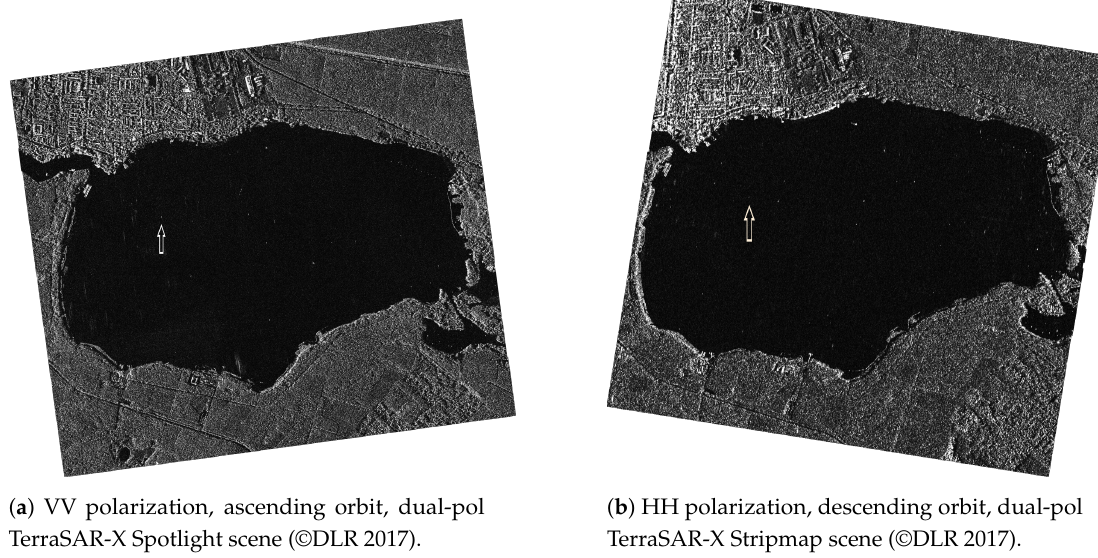
Figure 4. Subsets of two examples of dual-pol TerraSAR-X Stripmap scenes showing the lake Müggelsee and its